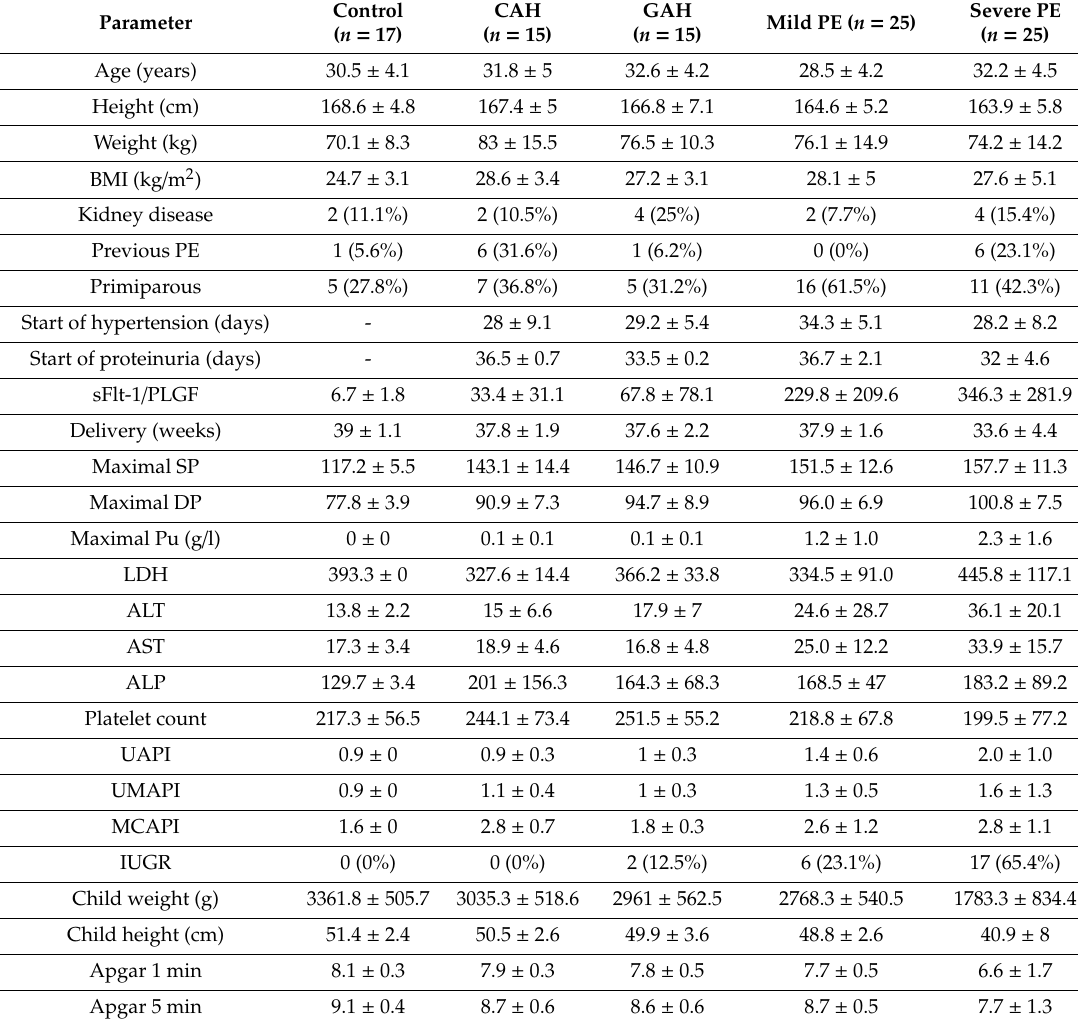
Table 1. Clinical and demographic data of